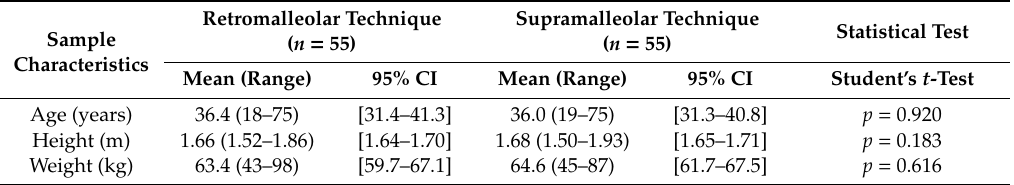
Table 2. Comparison of the sample characteristics for the two study groups (retromalleolar tibial nerve block (RMB) and supramalleolar tibial nerve block (SMB)). CI = confidence